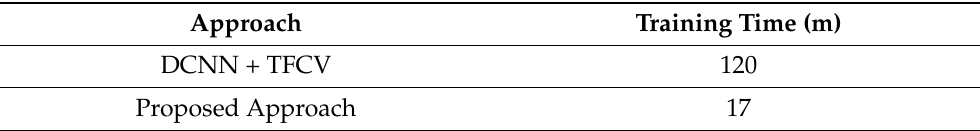
Table 16. Comparison of the Training Time with DCNN+TFCV